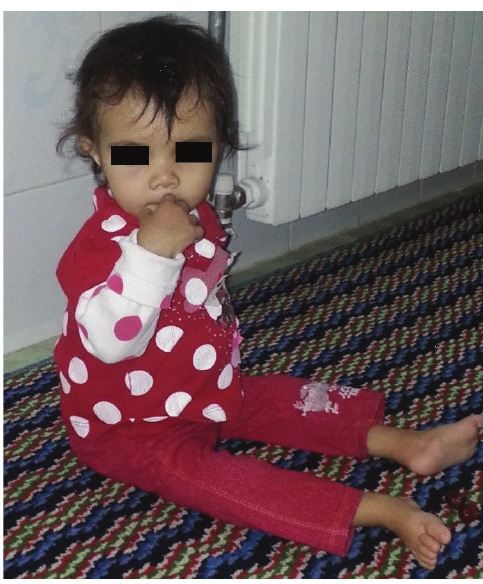
Figure 2: A one-year-old girl with failure to thrive and motor delay. Note facial dysmorphism (hypertelorism and broad nasal root).